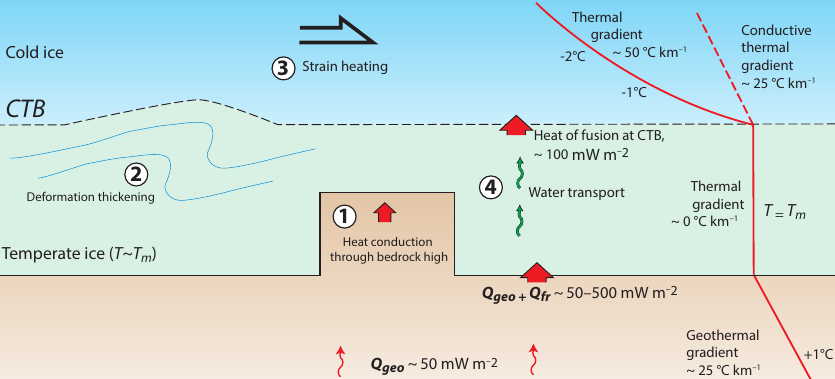
Figure 2. Constraints on the thermal growth of the temperate layer and mechanisms for heating cold ice above the CTB; numbers refer to text. Schematic thermal gradient of Borehole D is indicated in red line (after Lüthi et al., 2002). CTB is the cold-temperate boundary; Q geo is the geothermal heat flow; Q fr is the heat production by frictional